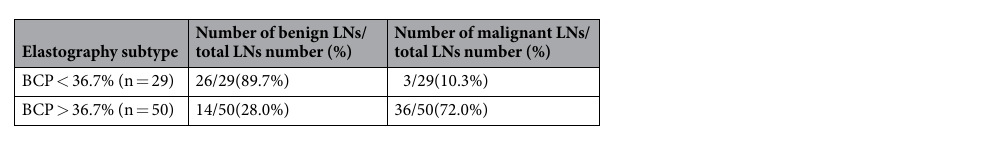
Table 3. EBUS elastography quantification and classification of LNs. EBUS, endobronchial ultrasound; LNs, lymph nodes; BCP, blue color